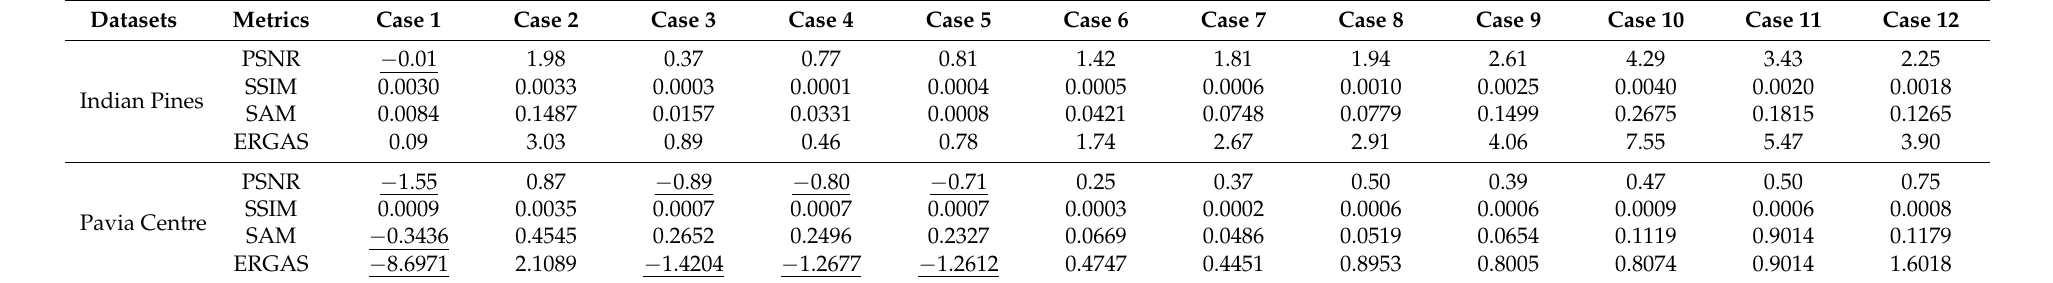
Table 4. The improvement of AL noise modeling, i.e., the improvement of ALDIP over DIP2D- (cid:96) 1 in four metrics. Positive numbers indicate positive effects, while negative numbers indicate negative effects. Negative effects are all